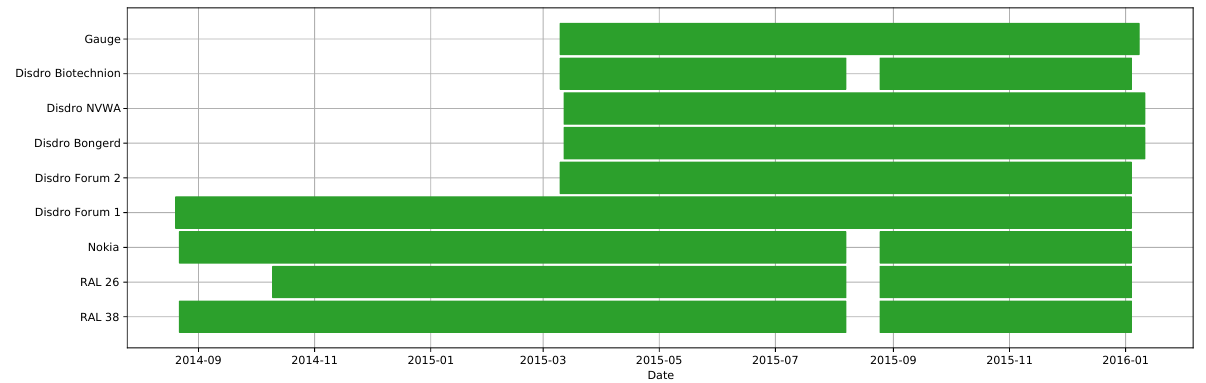
Figure 2. Operational period per instrument in the experimental setup.